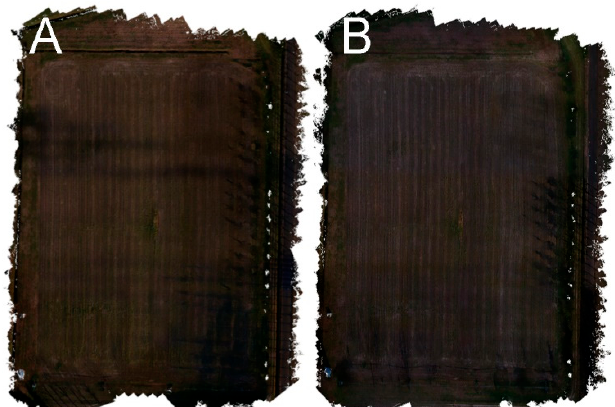
Figure 4. Examples of non-calibrated orthophoto reconstructed with images of the same day (day 1) ( A ), and randomly combining the same six zones over the three days of the experiment ( B ). Table 3. Mean ( ± SD) values of the parameters obtained after orthophoto reconstruction. Differences between the calibrated and non-calibrated reconstructions. Means with the same letter are not significantly different (Wilcoxon paired